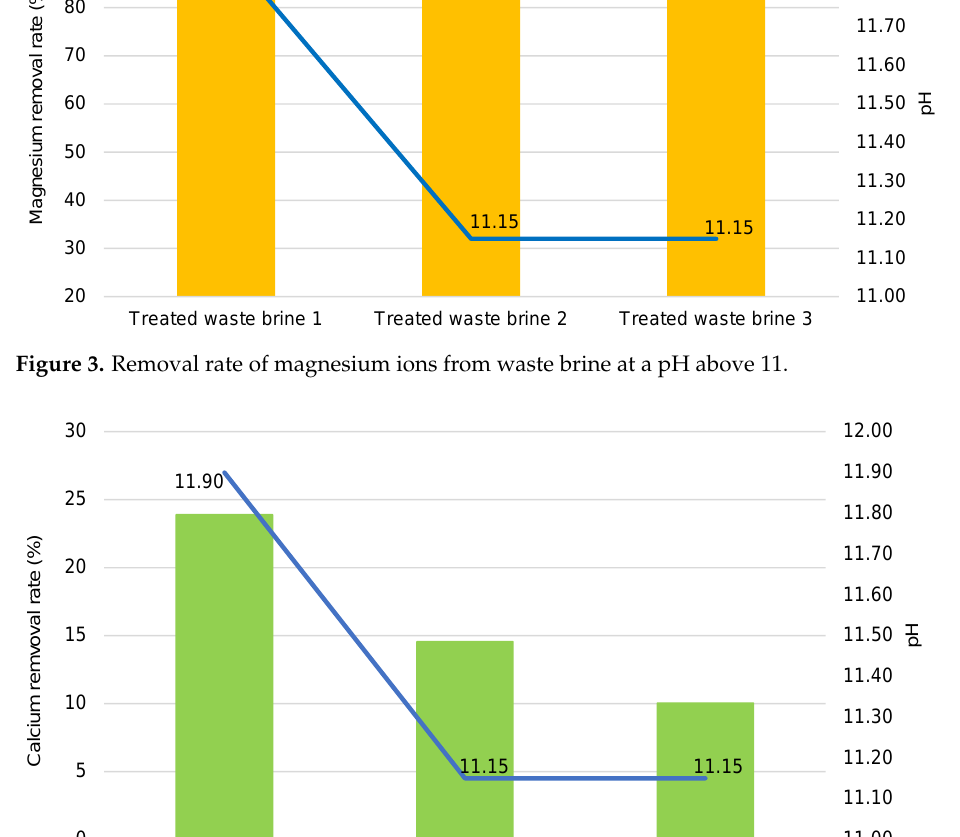
Figure 4. Removal rate of calcium ions from waste brine at a pH above 11.